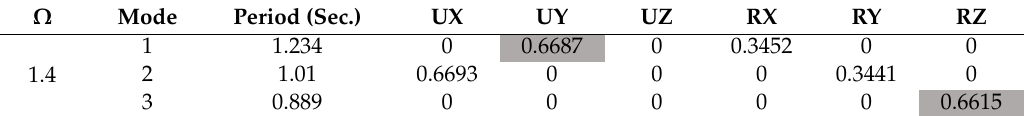
Table 2. Modal Participating Mass Ratio Buildings (with b / r = 3.28, 1 < Ty < 2 s, Ω = 1.4). Ω Mode